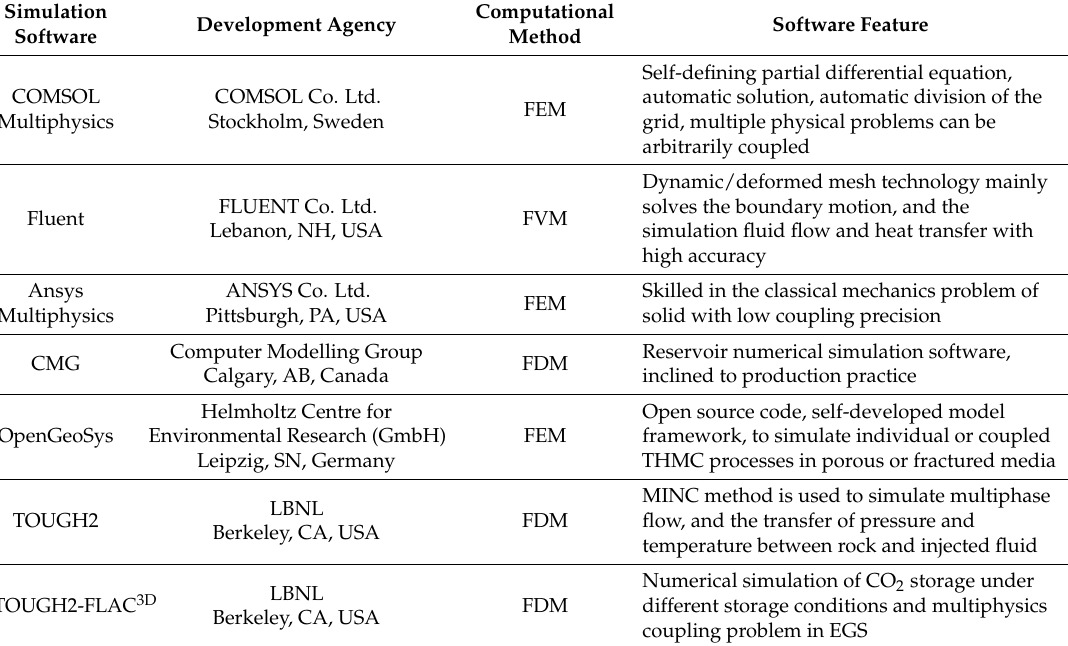
Table 1. Comparison of numerical simulation software for EGS